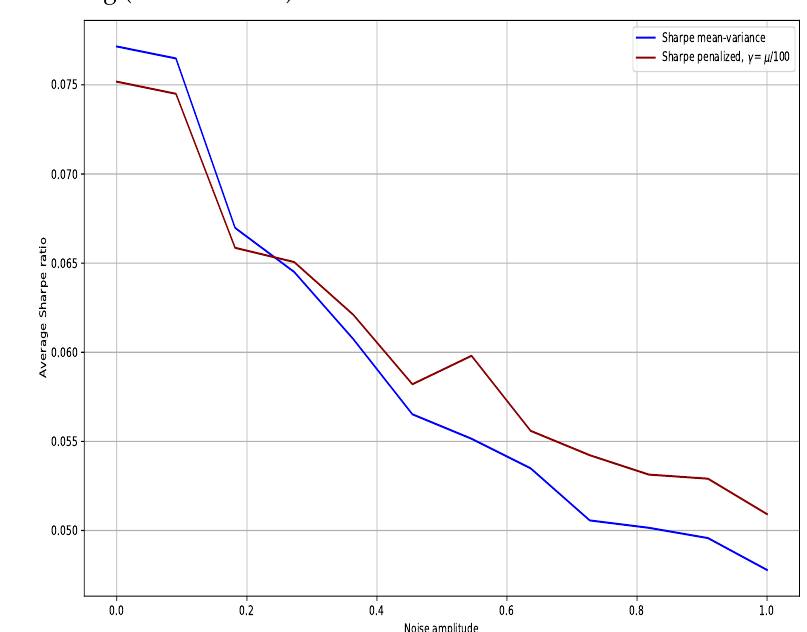
Figure 4. In this case the reference weights are equal to zero, and no Sharpe ratio is computed for the reference